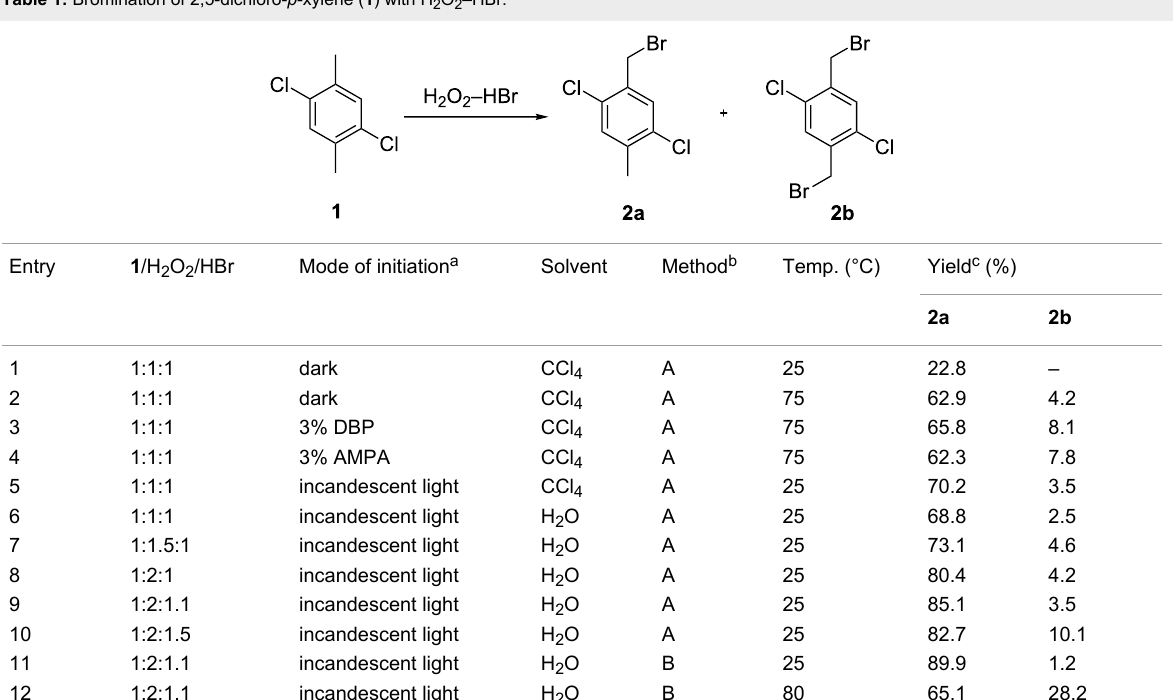
Table 2: Visible-light induced free-radical bromination of substituted p -xylenes with H 2 O 2 –HBr.